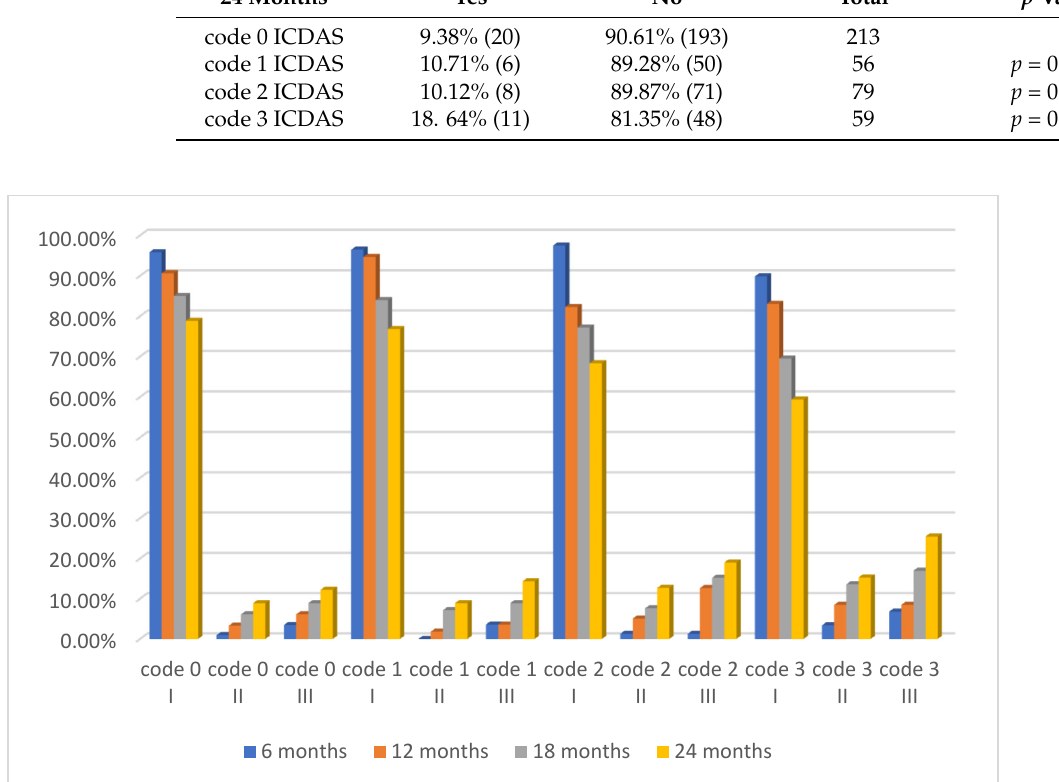
Figure 2. Retention based on Simonsen’s criteria at each follow-up interval.